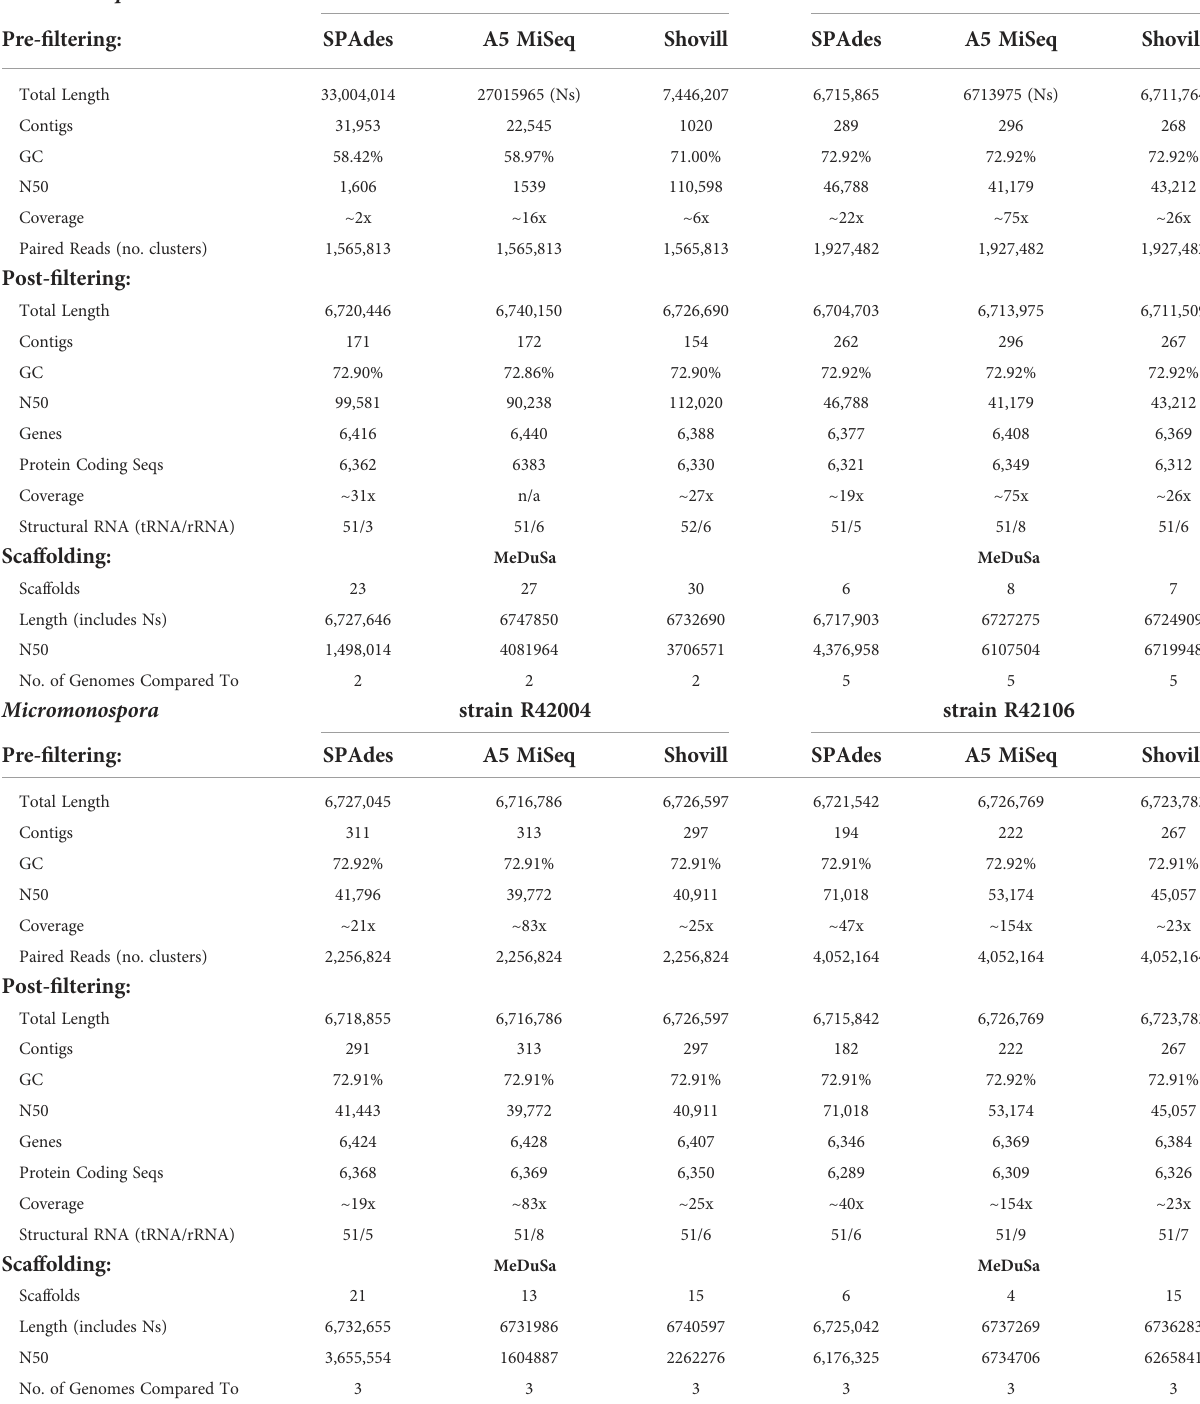
TABLE 3 Comparative assembly statistics for Micromonospora